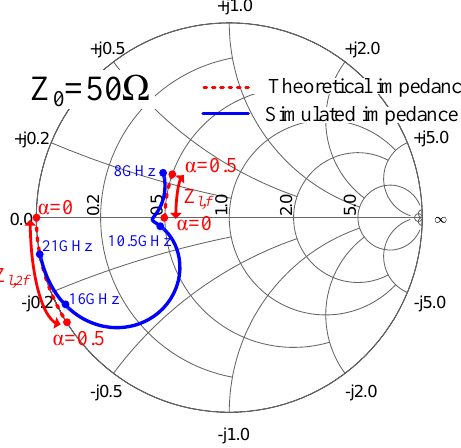
Figure 7. The simplified output matching network when C 01 is analyzed. Figure 8. The simulated response of the output matching network from 8 GHz to 21 GHz.